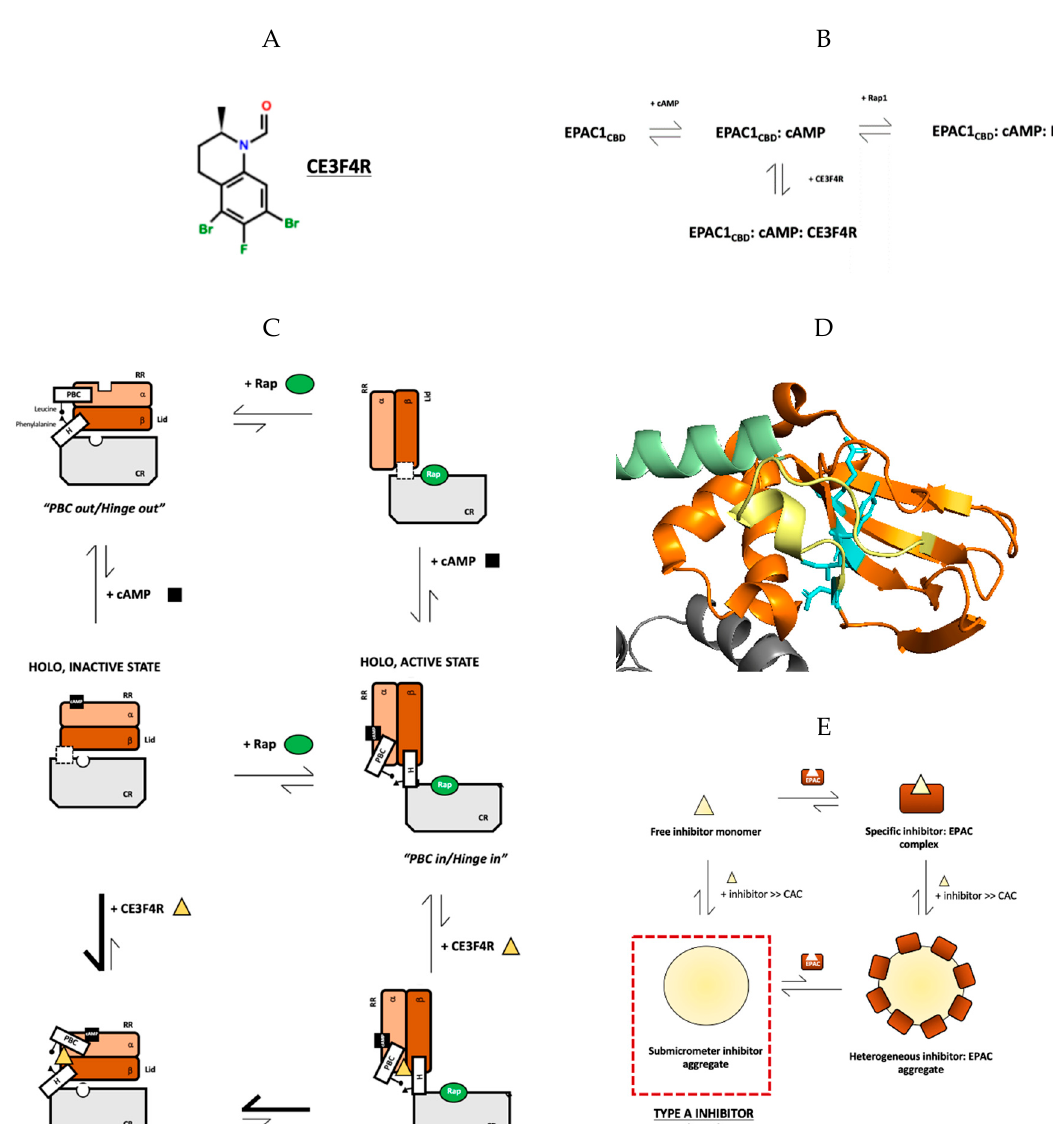
Figure 2. Specific and non-specific interactions of EPAC1 CBD and CE3F4R, a novel uncompetitive inhibitor. ( A ) The molecular structure of CE3F4R. ( B ) Schematic representing the uncompetitive mechanism of EPAC1 inhibition by CE3F4R. ( C ) Schematic summarizing the perturbation of the classic four-state thermodynamic cycle of EPAC activation by cAMP by CE3F4R binding, particularly highlighting the stabilization of the mixed holo inactive intermediate with the phosphate-binding cassette (PBC) in the active and hinge helix in the inactive conformation. Relative conformations of the PBC and hinge helix have not yet been elucidated in the holo, inactive and apo, active states and are thus not shown ( D ) Specific binding site of CE3F4R at the α / β subdomain interface of EPAC1 including residues Y242, I243, D267, and R294, as indicated in cyan, at the β -sheet facing the α -subdomain; the image shows homologous residues in EPAC2. Color scheme followed is consistent with Figure 1B. ( E ) Proposed thermodynamic cycle encompassing both specific enzyme:inhibitor binding as well as non-specific interactions between the two species as a result of colloidal aggregate formation; CE3F4R, as indicated on the figure, is a type-A inhibitor, forming inert aggregates that do not interact directly with the protein. Instead, they reduce overall inhibitory e ff ect by acting as sinks for monomeric inhibitors (Figure adapted from Boulton, S.; Selvaratnam, R.; Ahmed, R.; Van, K.; Cheng, X.; Melacini, G. Mechanisms of specific versus nonspecific interactions of aggregation-prone inhibitors and